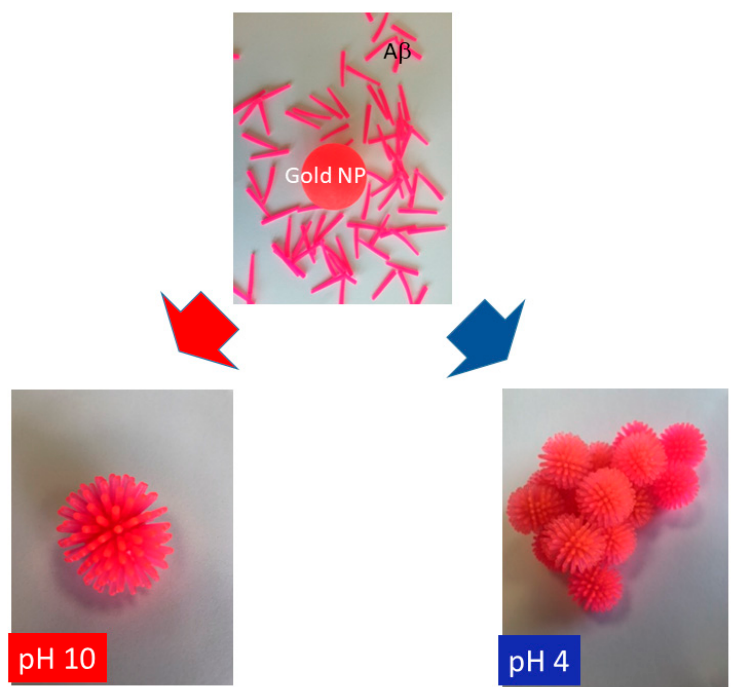
Figure 6. A demonstrative picture of peptides being adsorbed over a surface of gold nano-particle (NP) and adsorption of peptide with spiking out orientation under pH 10 (bottom left) and forming a network with each other in order to form gold colloid aggregates at pH 4 (bottom right). The color of peptide and gold colloid are shown in the same color.